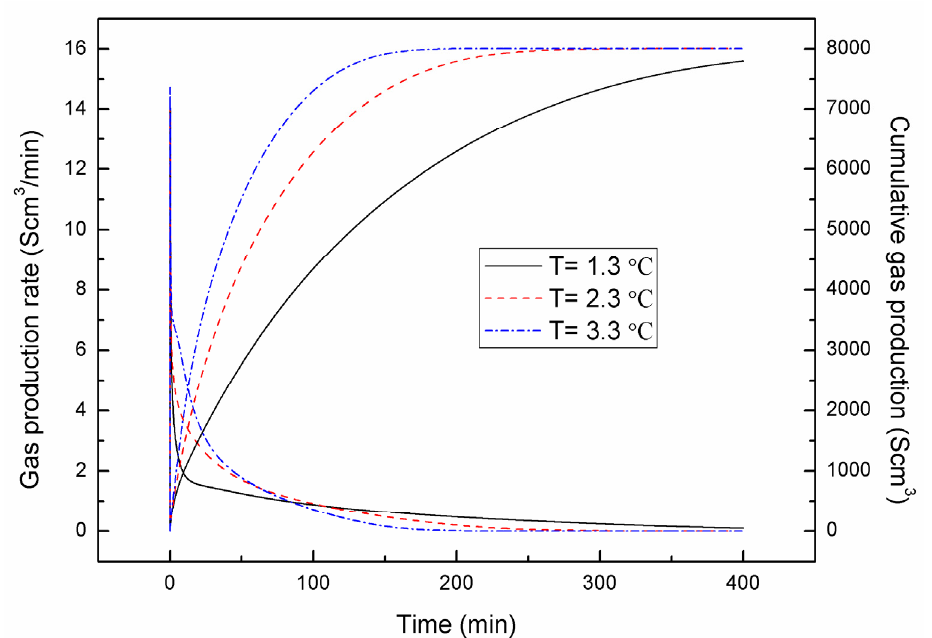
Figure 6. Gas production rate and cumulative gas production time evolution for different temperature with the same depressurizing